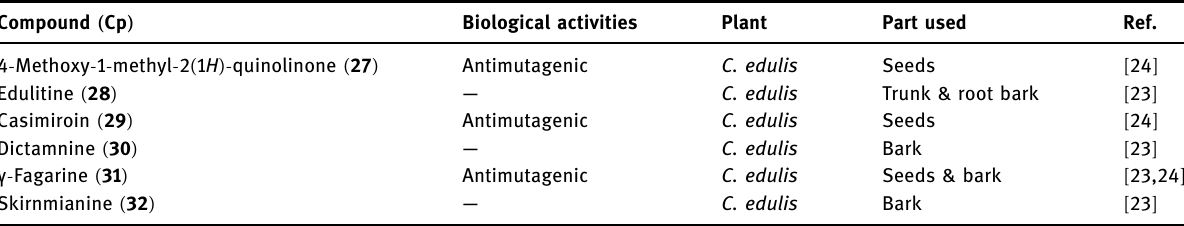
Table 7: Pharmacological properties of compounds obtained from Casimiroa species Compound ( Cp ) Biological activities Plant Part used Ref.